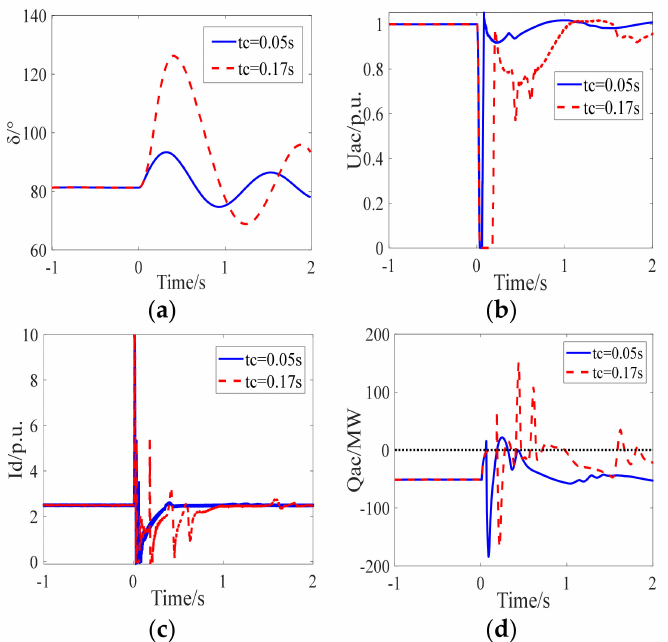
Figure 5. Comparison of the results of simulations with different fault durations. ( a ) Relative rotor angle, ( b ) inverter bus voltage, ( c ) DC current, and ( d ) reactive power.